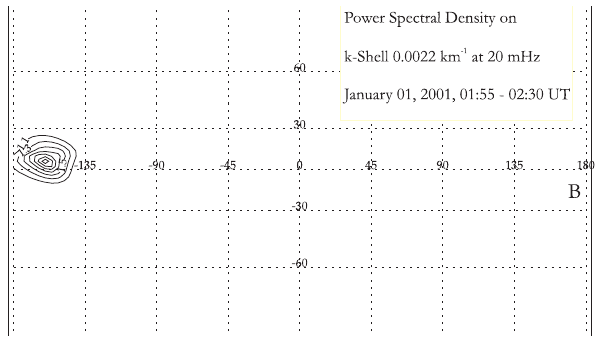
Fig. 6. Spectral density distribution on the k -shell k = 0 . 0022km − 1 resulting from applying the wave telescope to mea- surements in the magnetosheath during the interval 1 January 2001, 01:55–02:30UT. The logarithm of the power is displayed. ‘B’ de- notes the position of the mean magnetic field